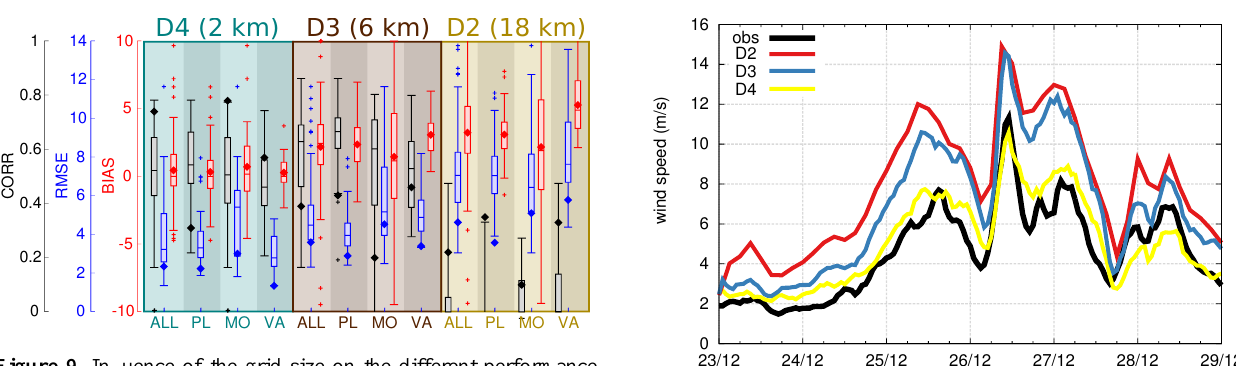
Figure 9. Influence of the grid size on the different performance measures, based on configuration C6 (Table 2). The figure depicts temporal and spatial correlation, RMSE and bias in a similar way to Fig. 5, but different spatial resolutions (grid sizes 18, 6 and 2km in domains D2, D3 and D4) and locations (ALL for all stations; PL for plains; MO for mountains, defined as those locations whose height exceeds 1200m; and VA for valleys) are shown separately. The locations of each type of station are indicated in Fig. 1.